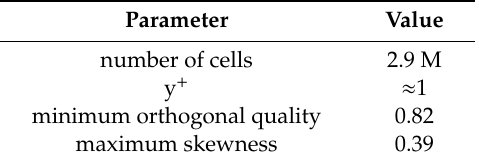
Table 2. Parameters of the grid used in numerical